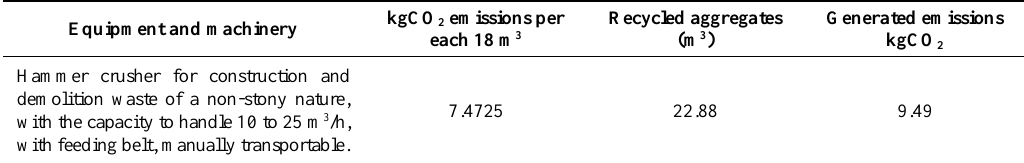
Table 8. CO 2 emissions of equipment and machinery for the recycling of CDW (Case 1).